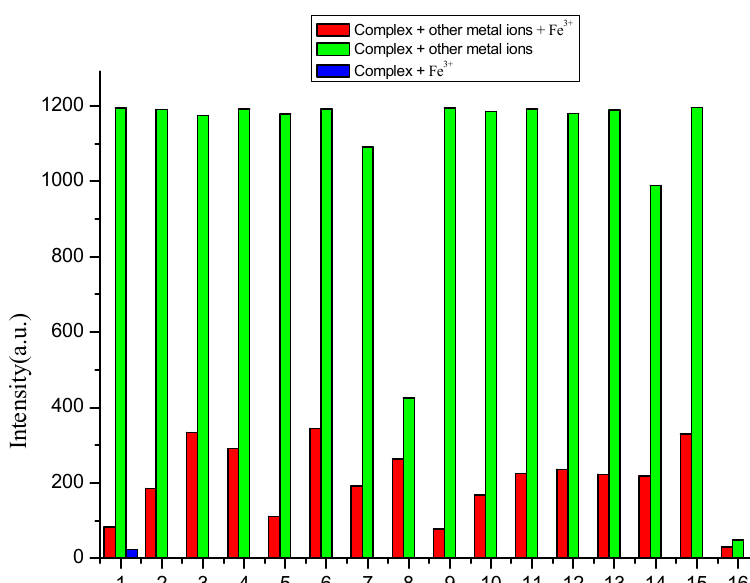
Figure 4. Changes in the fluorescence intensity of the complex [{Ru(bpy) 2 } 2 ( µ 2 -H 2 L)] 4 + (10 − 5 mol / L in CH 3 CN / H 2 O = 1:1, v / v , excitation wavelength = 450 nm) toward Fe 3 + in the presence of other metal ions. The red bars represent the fluorescence intensity of [{Ru(bpy) 2 } 2 ( µ 2 -H 2 L)] 4 + when 5.0 equiv. of Fe 3 + were added in the presence of: 1 Ag + , 2 Ba 2 + , 3 Ca 2 + , 4 Cd 2 + , 5 Co 2 + , 6 Cr 3 + , 7 Fe 2 + , 8 Hg 2 + , 9 Li + , 10 Mg 2 + , 11 Mn 2 + , 12 Na + , 13 Ni 2 + , 14 Pb 2 + , 15 Zn 2 + , 16 Cu 2 + ; the green bars represent the changes in fluorescence intensity of [{Ru(bpy) 2 } 2 ( µ 2 -H 2 L)] 4 + when other metal ions were added, respectively. The blue bar represents the fluorescence intensity of [{Ru(bpy) 2 } 2 ( µ 2 -H 2 L)] 4 + when 5.0 equiv. of Fe 3 + were added.